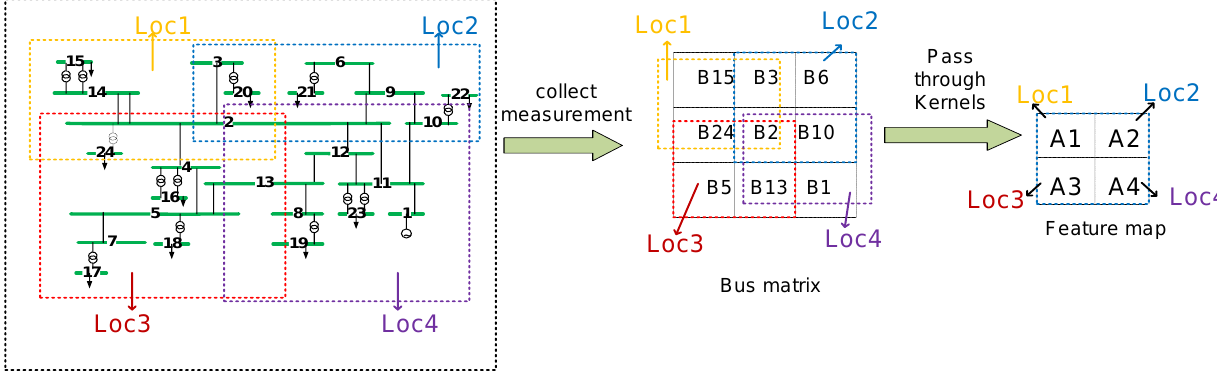
Figure 2. Illustration of system area mapping.